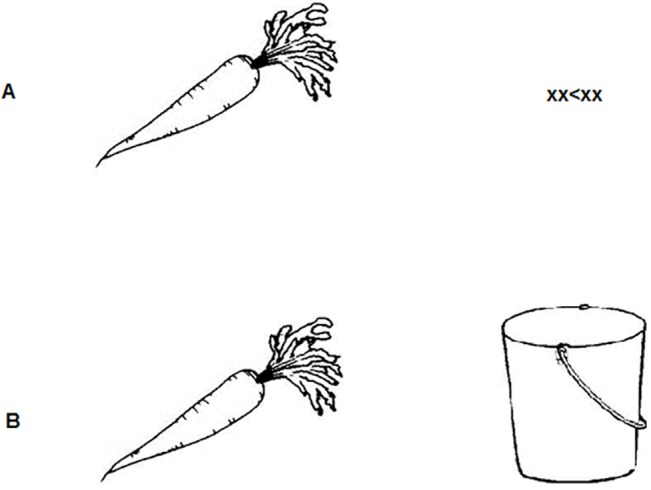
Illustration of the visual stimulus displays used in the single object task (A) and in the double object task (B).